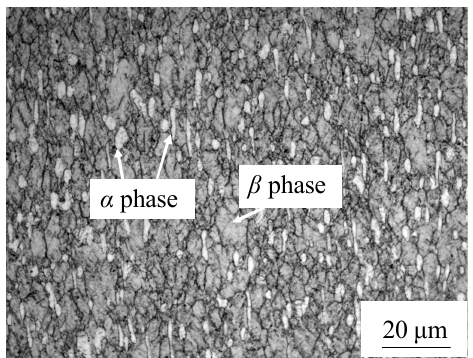
Figure 1. Initial microstructure of the Ti–5Al–2Sn–2Zr–4Mo–4Cr alloy.